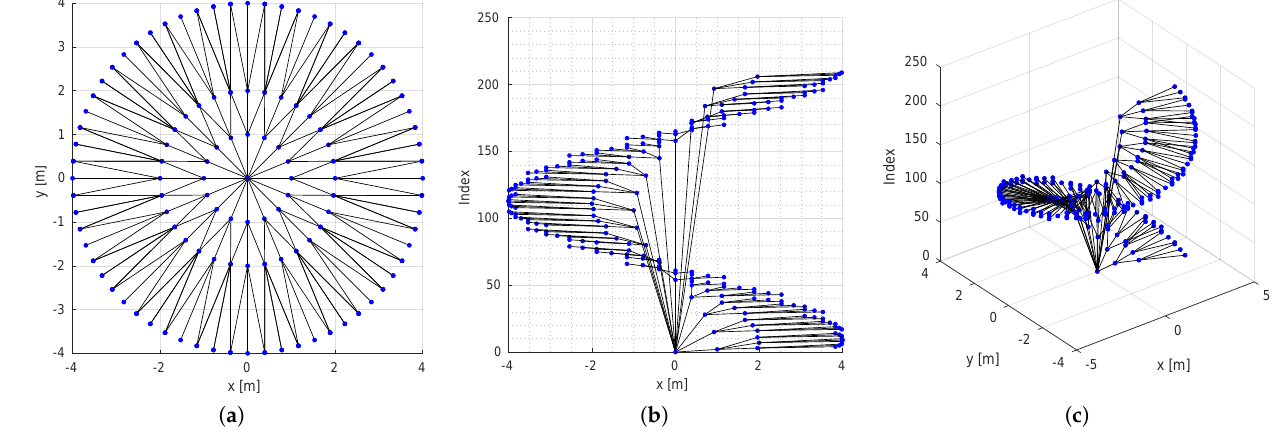
Figure 2. ( a ) A lattice with ( K , N T , N B , N L , r 0 ) = ( 2,16,3,3,1 ) . In black, we see the edges that belong to the graph. In ( b , c ) it is possible to view an exploded view of the lattice, which is plotted in 3D to emphasize the fact that two non-neighbor nodes may have the same position in the plane. The graph is composed of a single tree and there is only one path from each vertex to the